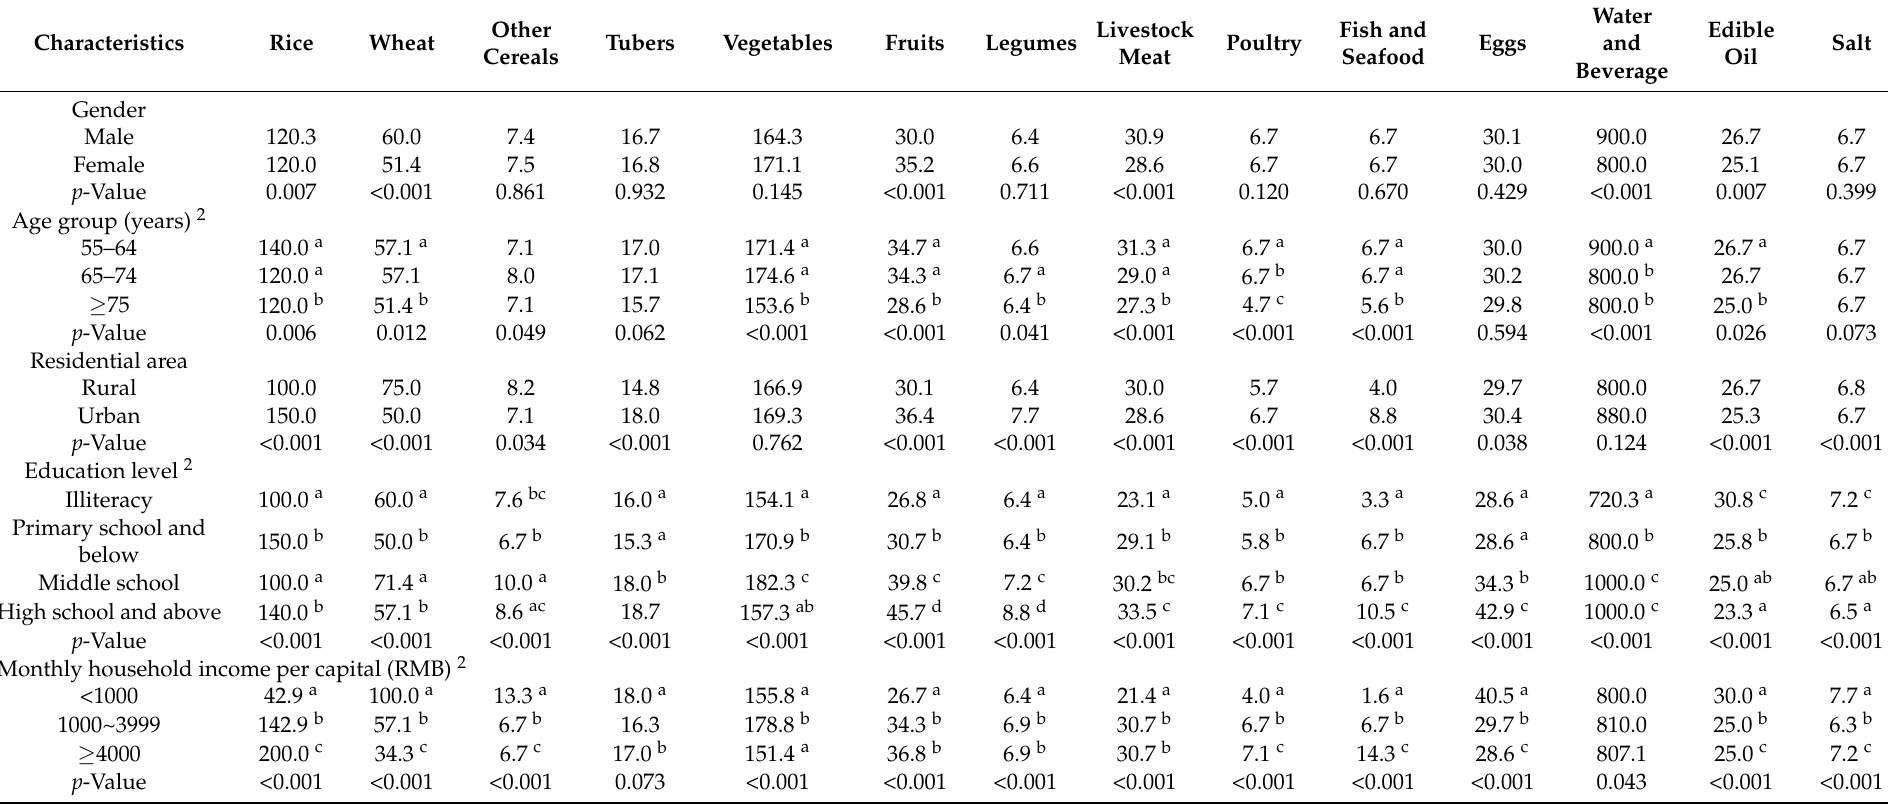
Table 2. Consumption amount of foods by characteristics among Chinese adults aged 55 years and above in four provinces in CCSNSD 2020 1